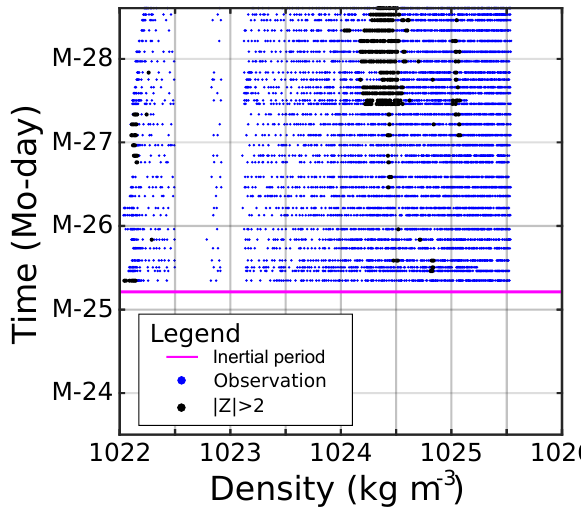
Figure 9. Time series of CTD observations for LDA. Observations with | Z | < 2 plotted in green, | Z | > 2 in black. End of statistical baseline definition period shown in magenta.